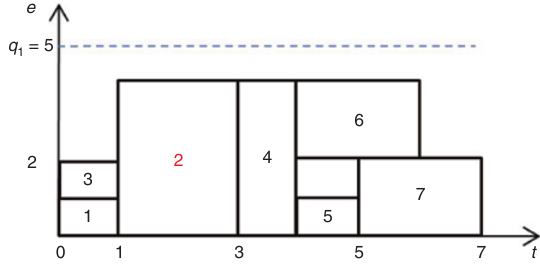
Figure 3: Schedule with TL